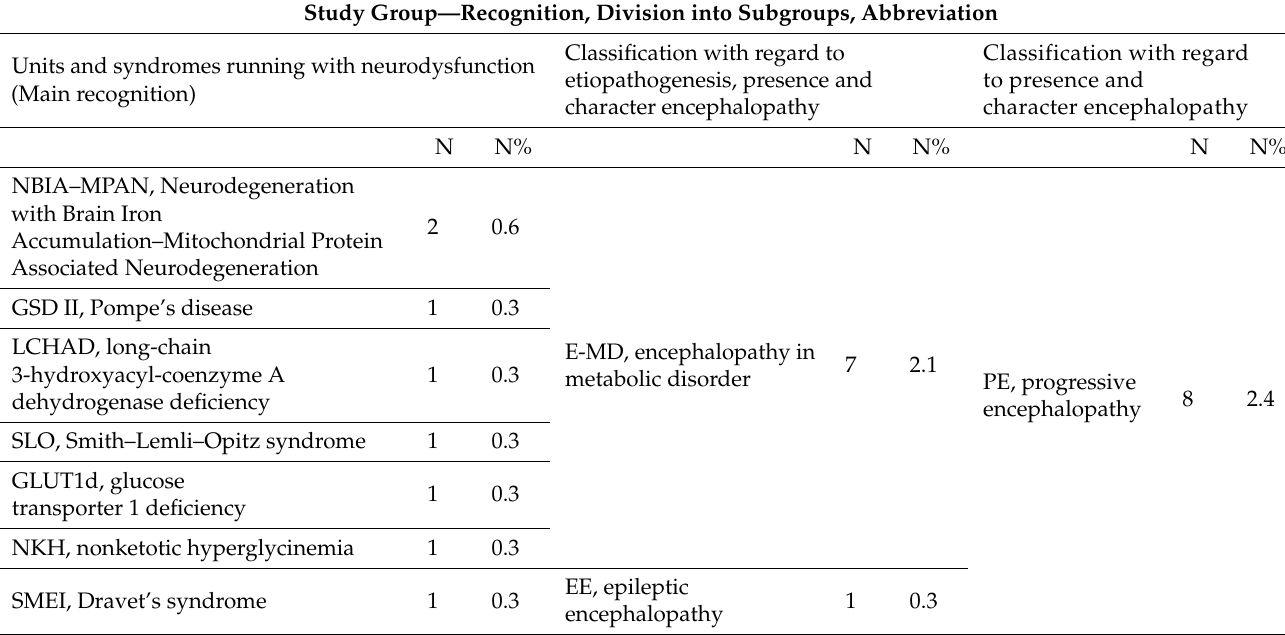
Table 1. Characteristics of the study